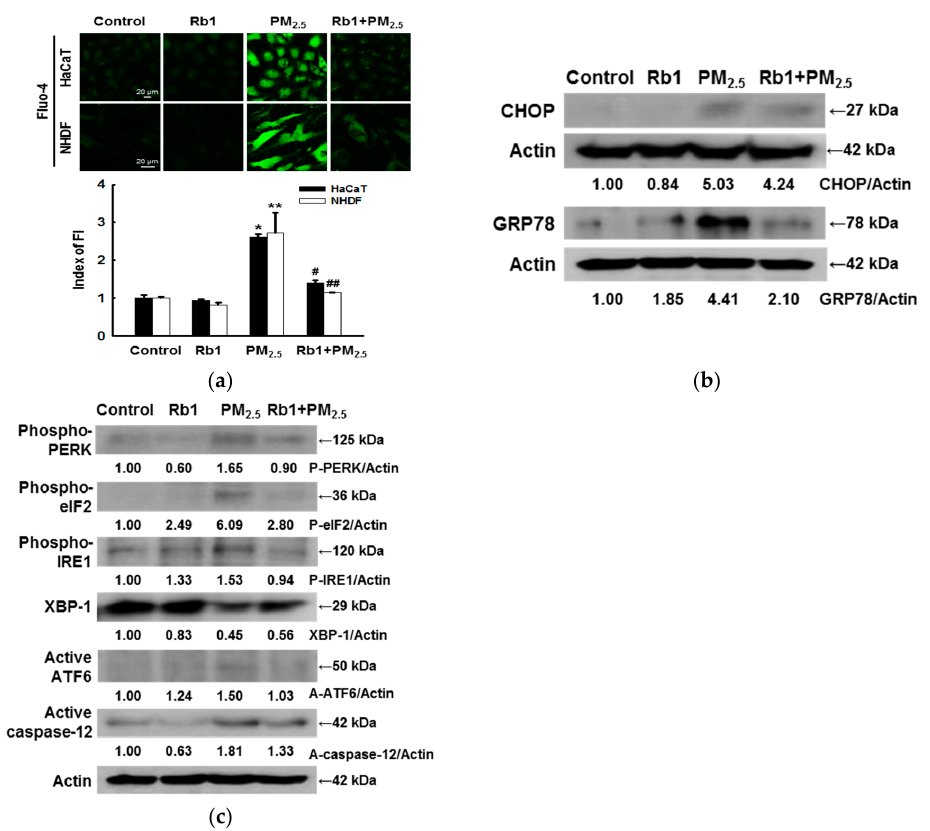
Figure 4. Ginsenoside Rb1 confers protection from PM 2.5 -induced ER stress. Cells were